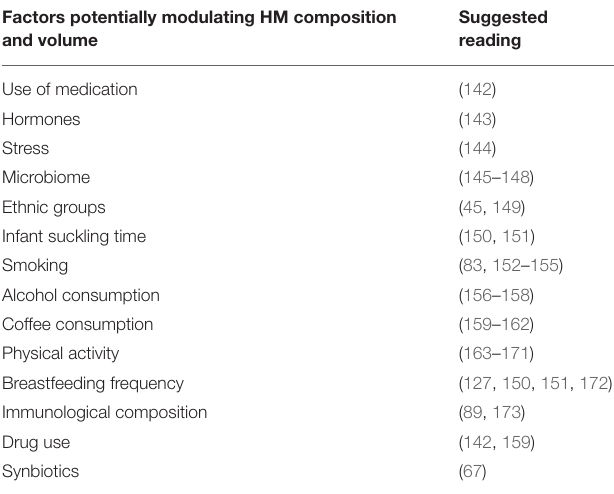
TABLE 2 | Further reading for factors with potential impact on human milk. Factors potentially modulating HM composition and volume